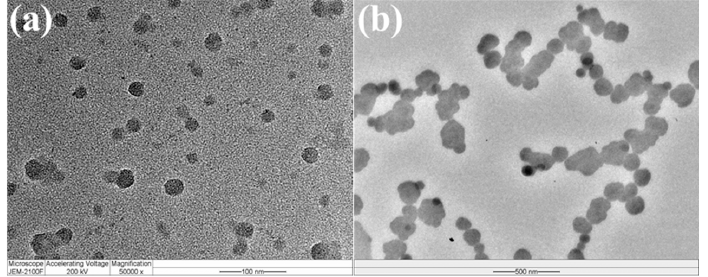
Figure 6. TEM images of ( a ) the PEGylated fluorescent NPs and ( b ) the resulting NPs without the conducting of ATRP. conducting of